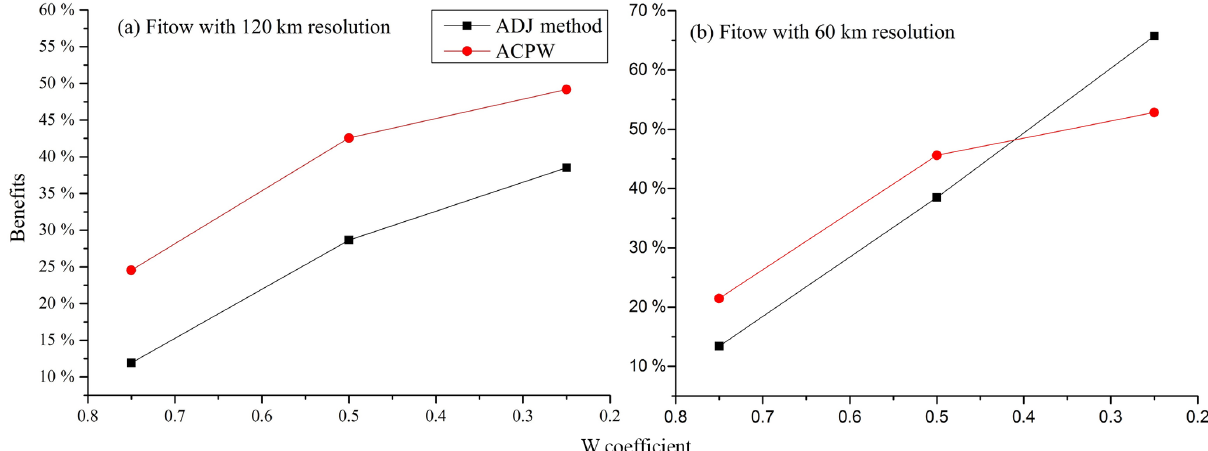
Figure 9. Benefits (in %) gained from reducing the CNOPs to W × CNOPs for the ADJ method and the ACPW algorithm across the entire domain for TC Fitow (2013). The x coordinate represents the W coefficient values, and the y coordinate denotes the benefits (in %) derived from the two methods. The ADJ method is presented as the black line with squares, and the ACPW result is the red line with